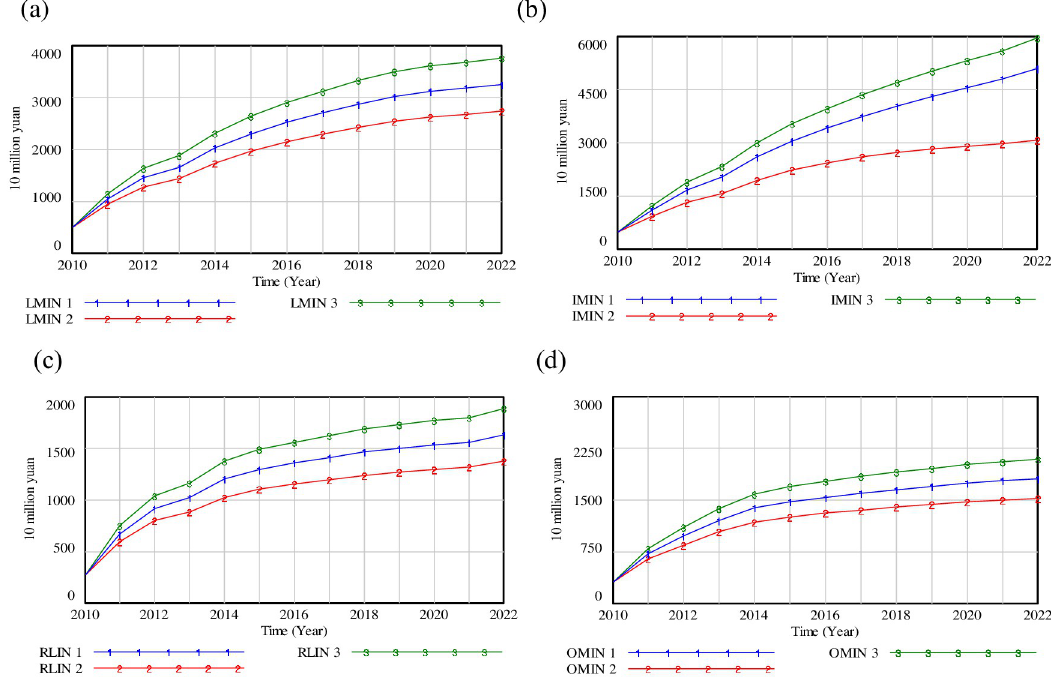
Fig 7. Simulation results of adjusting of industrial structure. (a) LMIN; (b) IMIN; (c) RLIN; (d) OMIN.